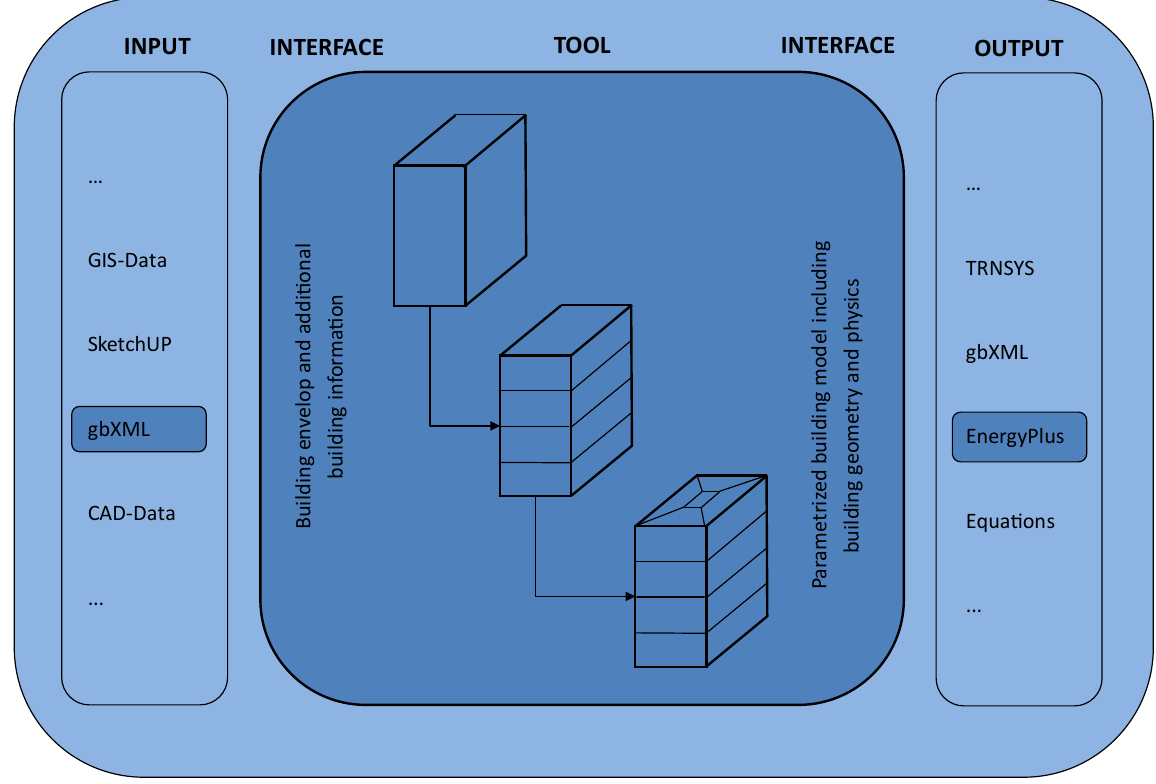
Figure 5. Schematic overview of the developed tool for building model creation.